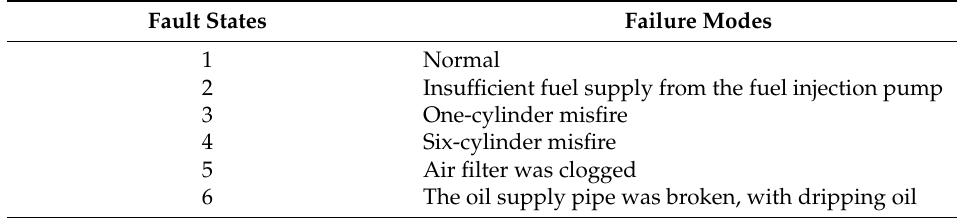
Table 2. The preset failure modes of the diesel engine.